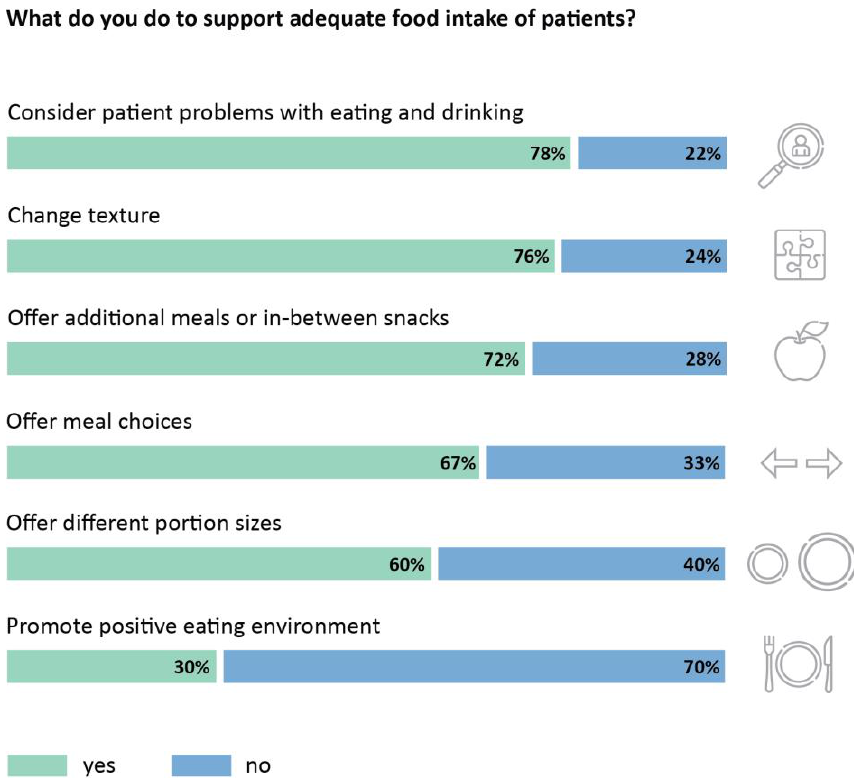
Figure 5. Implementation of strategies that promote a positive eating environment ( n = 2793 units).